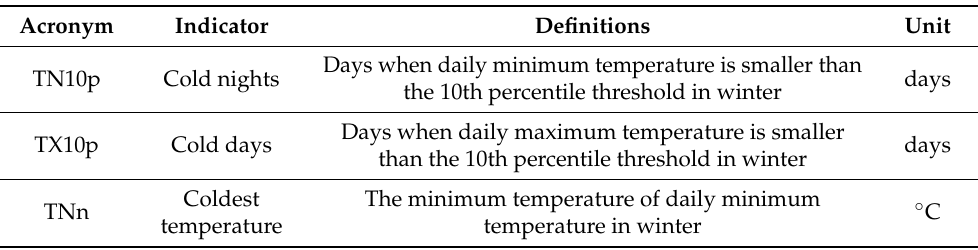
Table 1. Definitions of winter extreme low temperature (WELT) indices from the World Meteorologi- cal Organization (WMO).